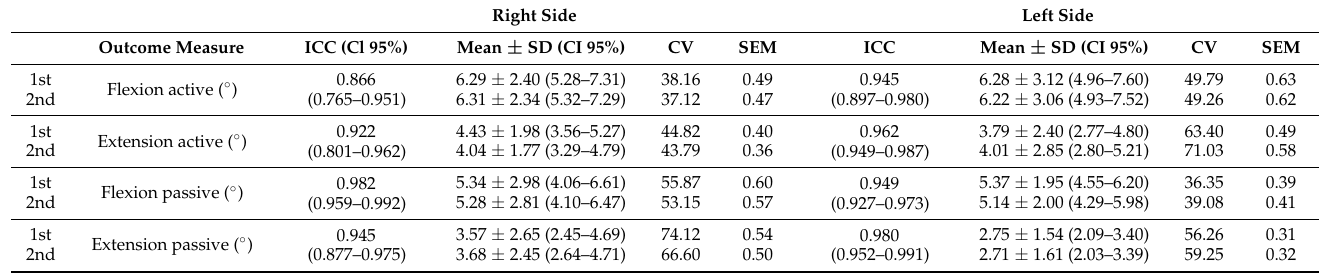
Table 2. Reliability results for active and passive joint position sense (JPS) tests.